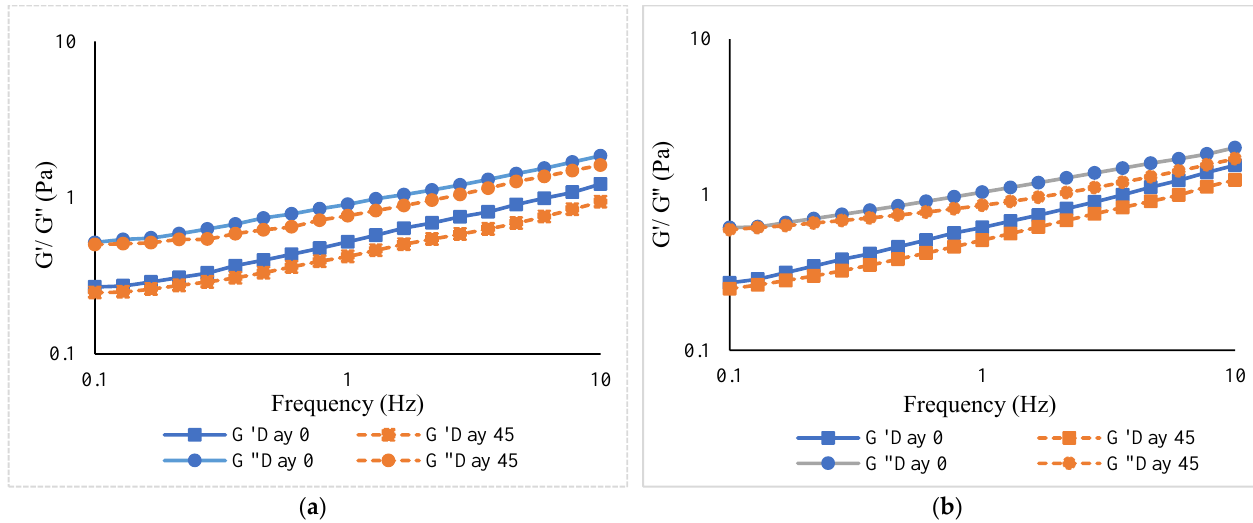
Figure 6. Storage modulus—G′ and loss modulus—G″ of emulsions stabilized by ( a ) freeze-dried (FD) and ( b ) spray-dried (SD) fish myofibrillar protein (FMP) modified with 0.5% tannic acid at day 0 and 45 of storage at 28 °C.